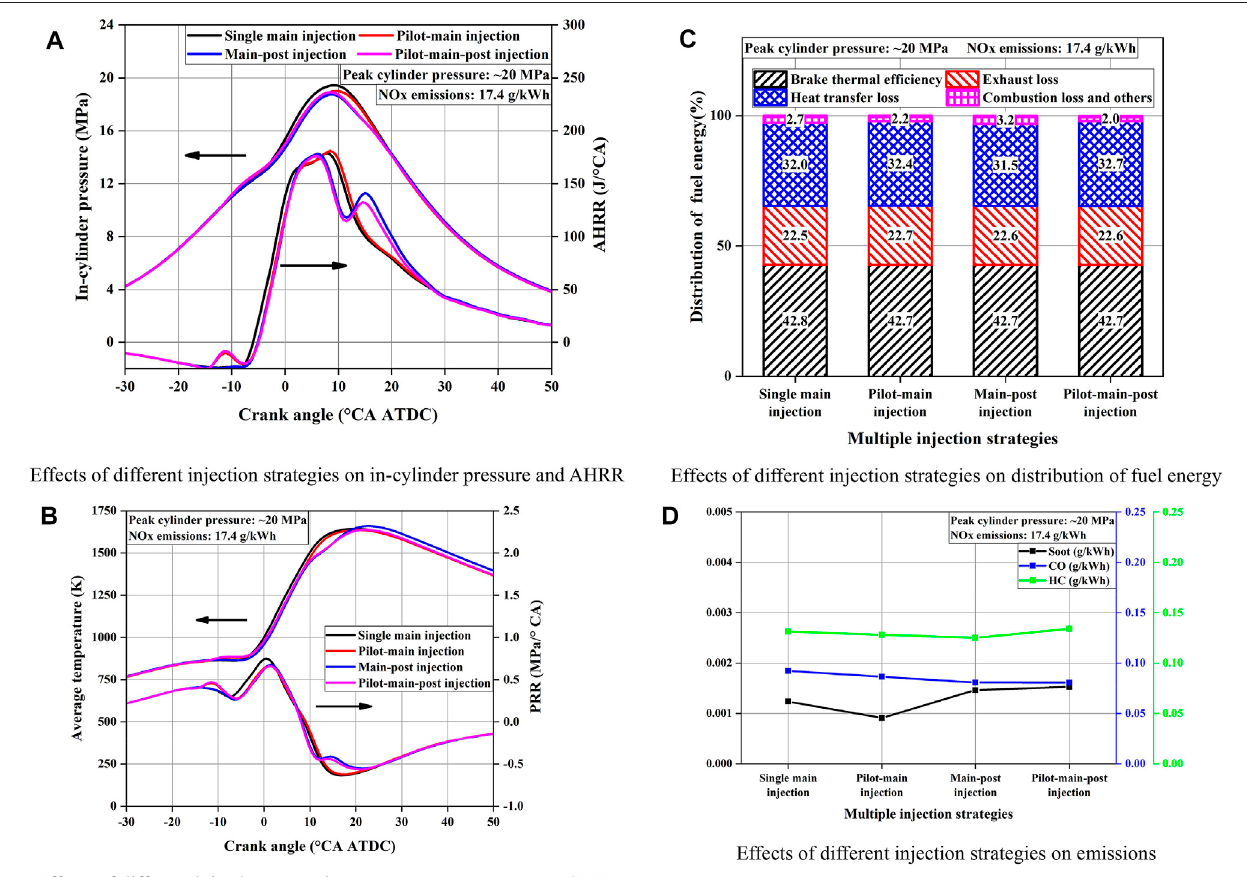
Frontiers in Energy Research |